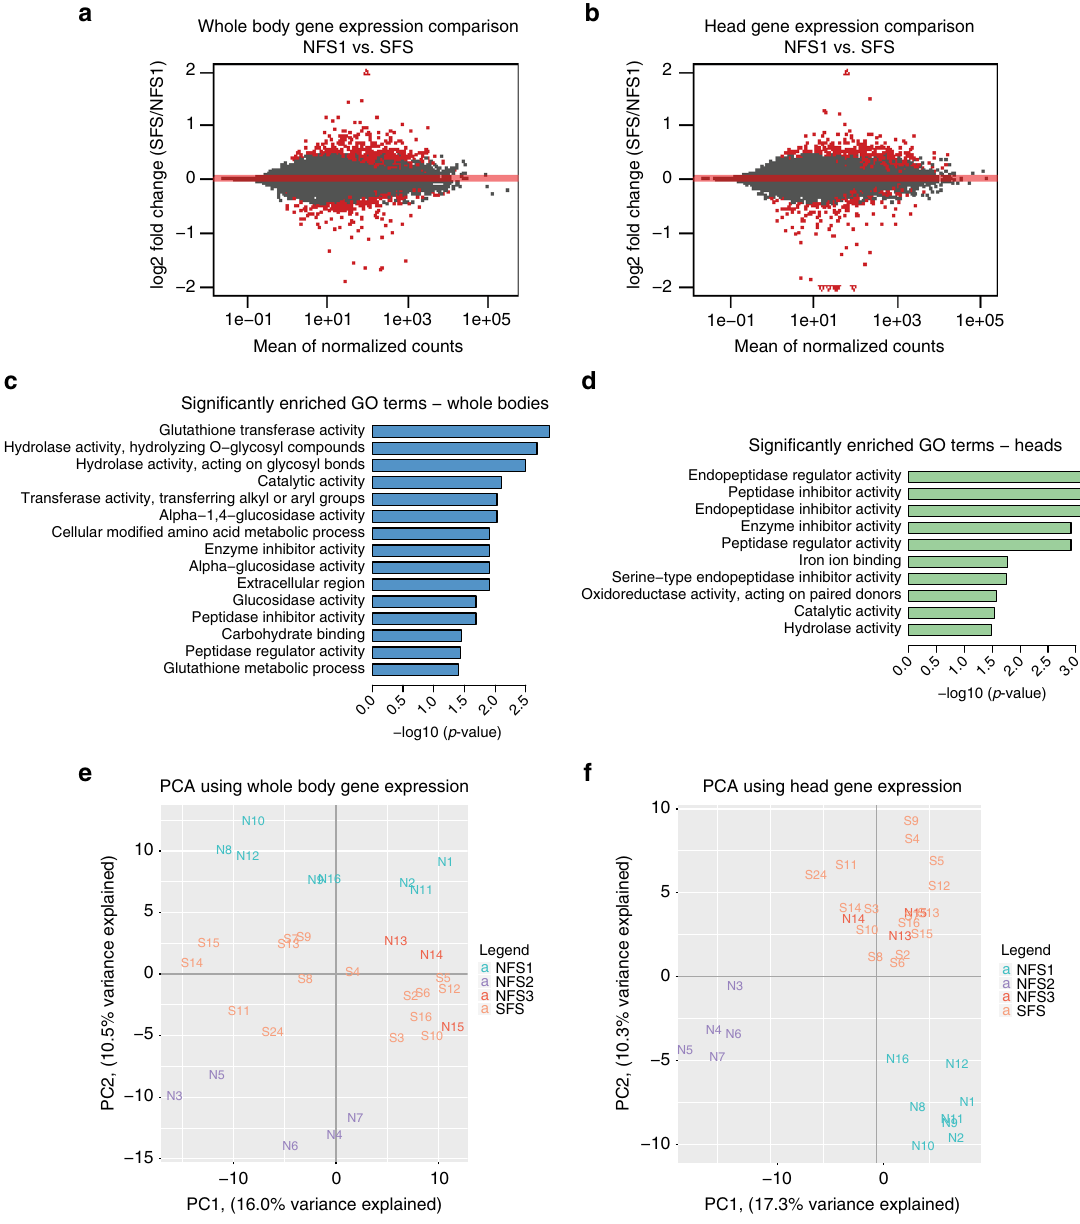
Fig. 2 Gene expression differences between NFS1 and SFS populations re fl ect genetic differences. a , b Scatter plot showing gene expression differences between the 8 NFS1 and 16 SFS fl y lines in whole bodies a and heads b . Red points represent genes with signi fi cantly different expression levels (Benjamini- Hochberg adjusted p -value < 0.05, Wald test, DESeq2). c , d Signi fi cantly enriched GO-terms of genes over-expressed in SFS in whole bodies c and heads d (Benjamini-Hochberg adjusted p -value < 0.05, GOseq using the Wallenius approximation). Abbreviated GO-terms for c , d : “ transferase activity, transferring alkyl or aryl groups ” represents “ transferase activity, transferring alkyl or aryl (other than methyl) groups ” ; “ oxidoreductase activity, acting on paired donors ” represents “ oxidoreductase activity, acting on paired donors, with incorporation or reduction of molecular oxygen ” . e , f PCA of whole body e and head f gene expression for all 32 Evolution Canyon fl y lines, with 5 fl ies represented per line. The sub-populations are labeled as follows: NFS1 (turquoise), NFS2 (purple), NFS3 (red), SFS